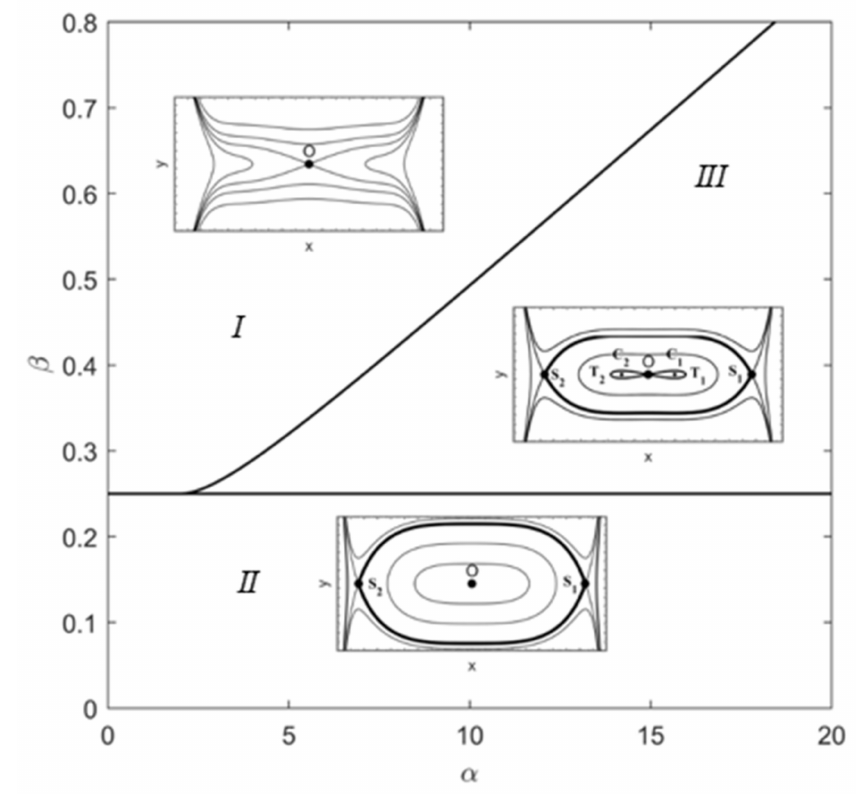
Figure 2. Orbits of the unperturbed system (6) under different values of α and β